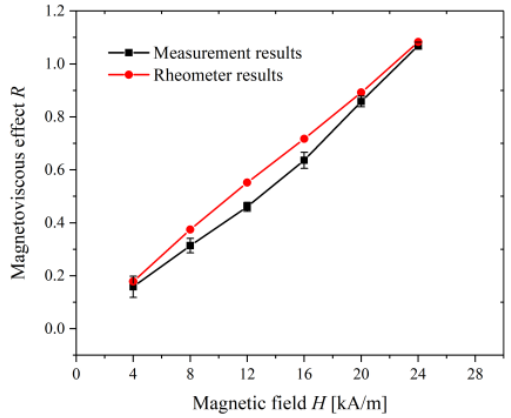
Figure 10. The influence of magnetic flux density on the magnetoviscous effect of magnetic fluid. When the magnetic flux density is low, the magnetic moment of the particles tries to align along the direction of the magnetic field. The magnetic torque offsets the free rotation of the particles in the flow, increasing fluid viscosity. According to the physical model of the hindrance of rolling on the particles by Hall and Busenberg [25], the viscosity η r of magnetic fluid under magnetic field is as follows: